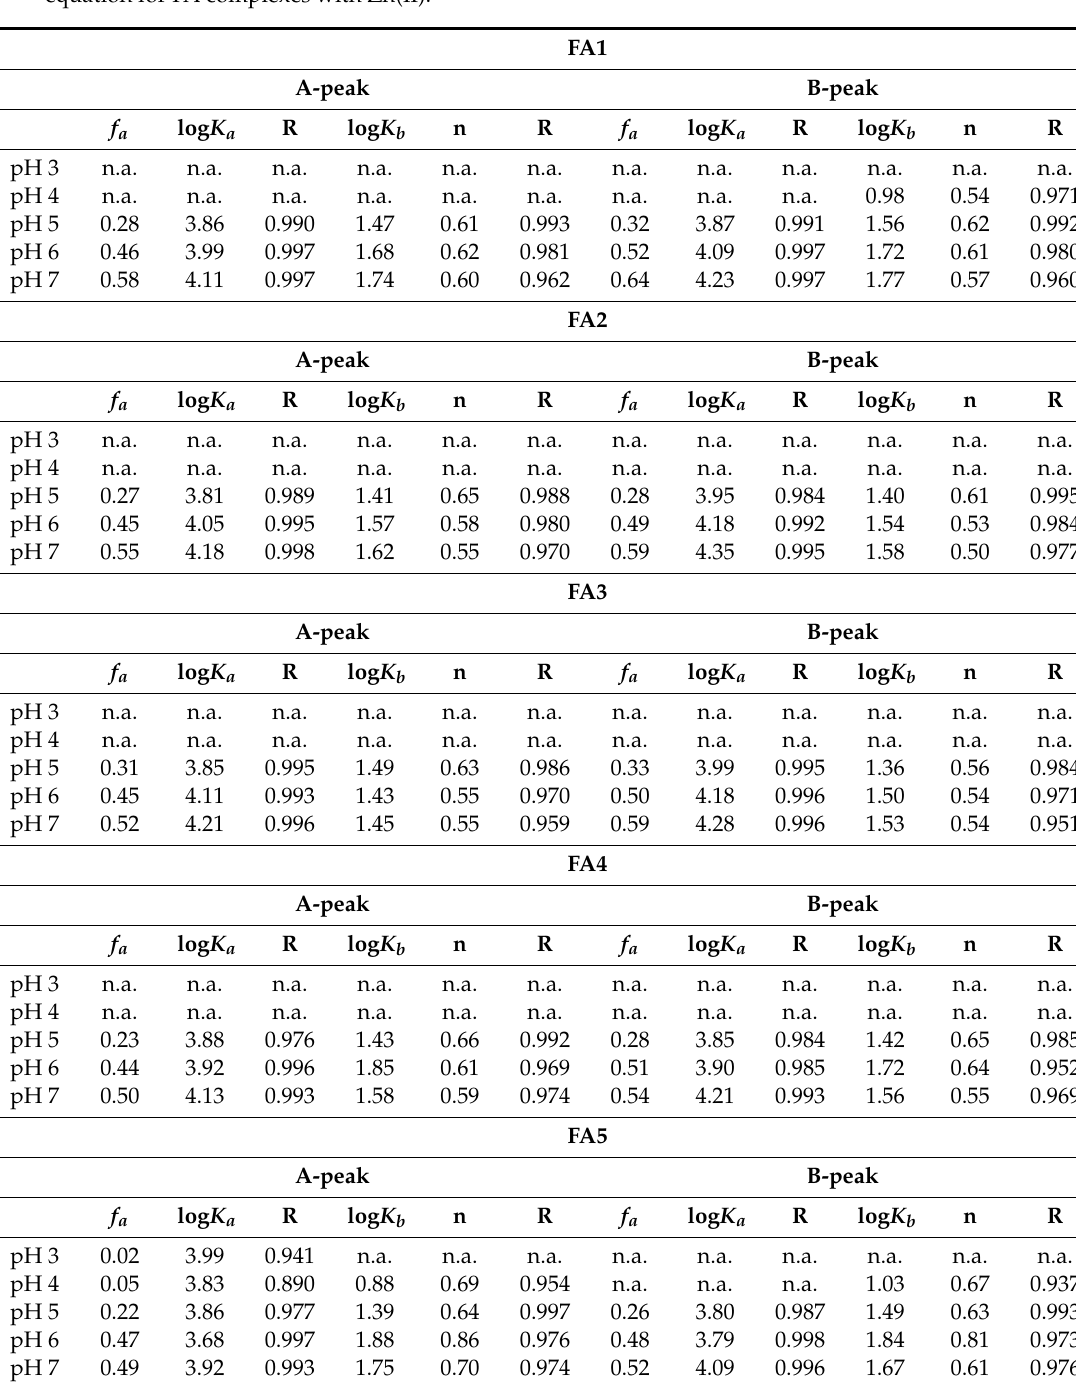
Table 3. Binding parameters calculated from modified Stern–Volmer equation and double logarithmic equation for FA complexes with